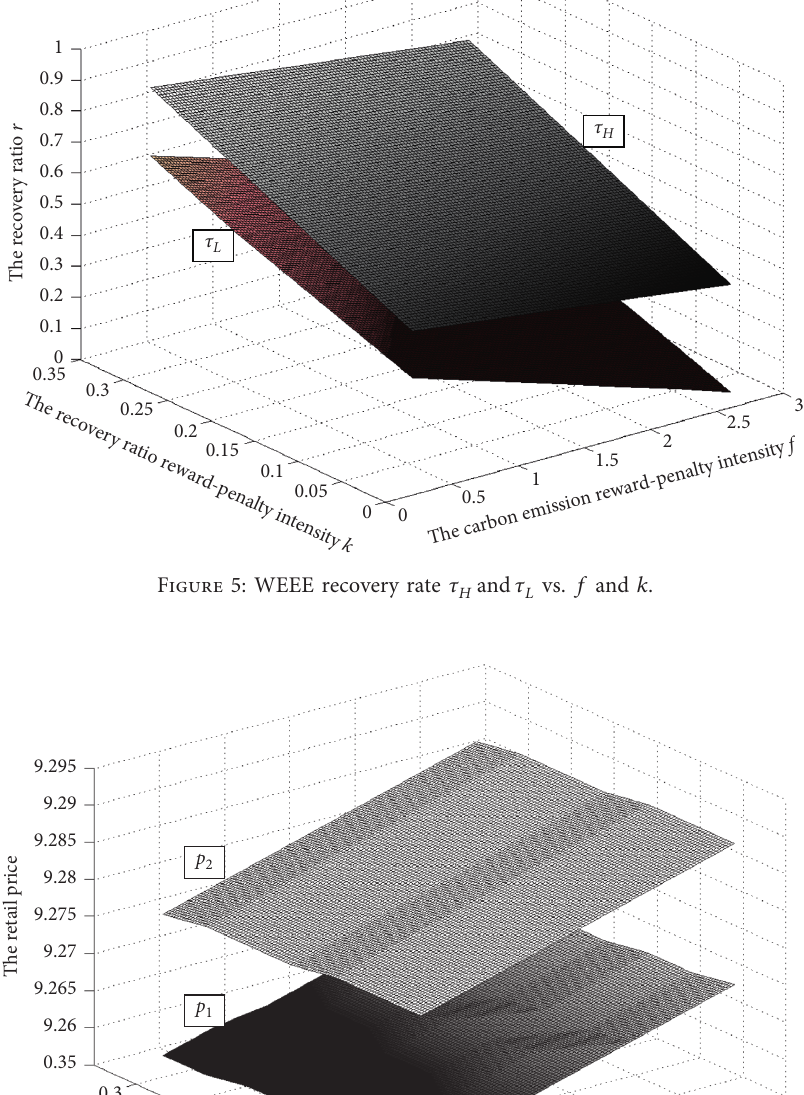
and p vs. f and k 1 2